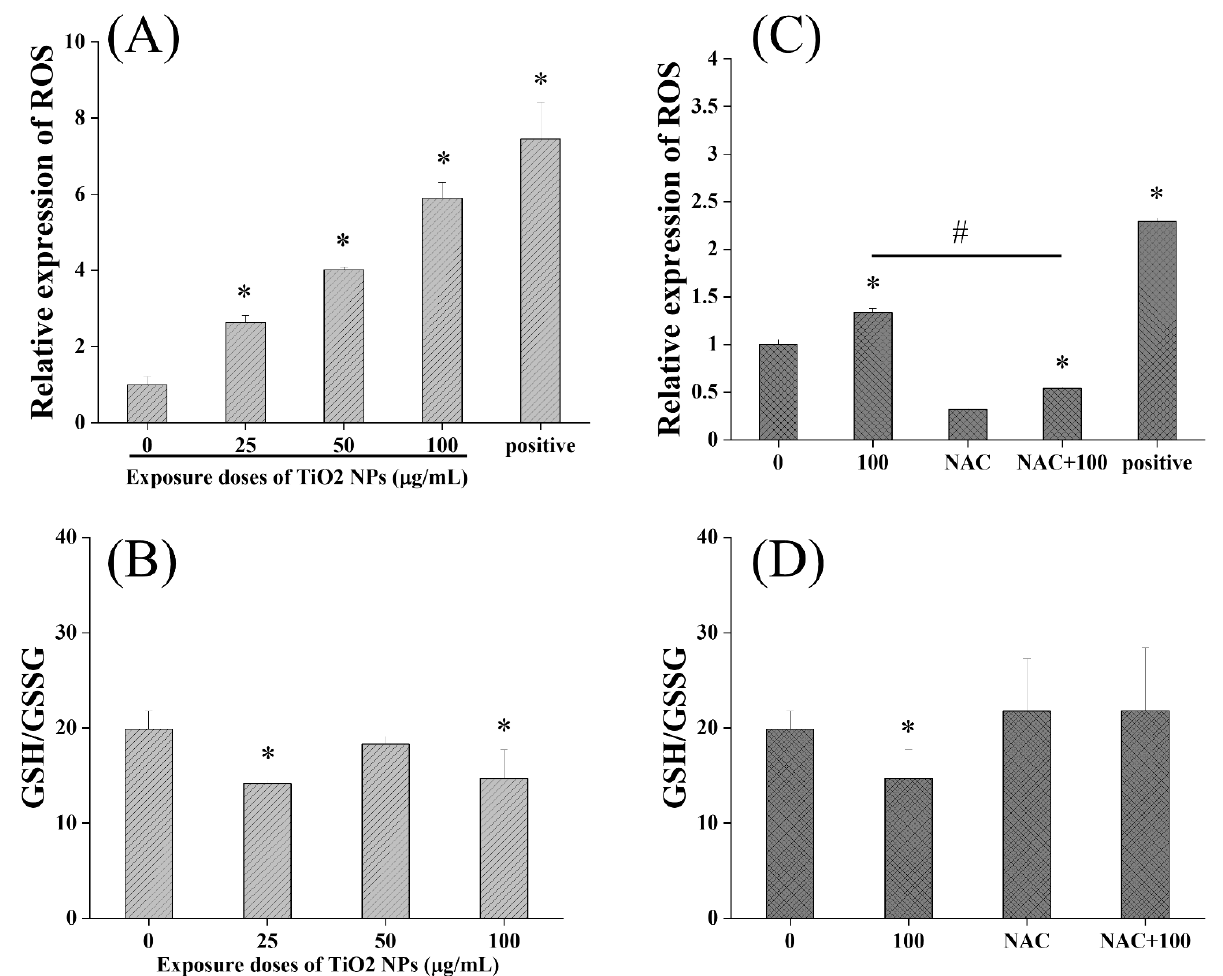
Figure 6. Effects of TiO 2 NPs on oxidative stress in BEAS-2B cells. ( A ) TiO 2 NPs induced significantly increased levels of ROS in BEAS-2B cells with a good dose – response relationship. ( B ) TiO 2 NPs induced a significant decrease in GSH/GSSG at doses of 25 and 100 µg/mL. ( C , D ) After antioxidant intervention by NAC, the oxidative stress induced by TiO 2 NPs was significantly recovered. Significant difference from the control (* p < 0.05), significant difference from the 100 µg/mL TiO 2 NP group (# p < 0.05).